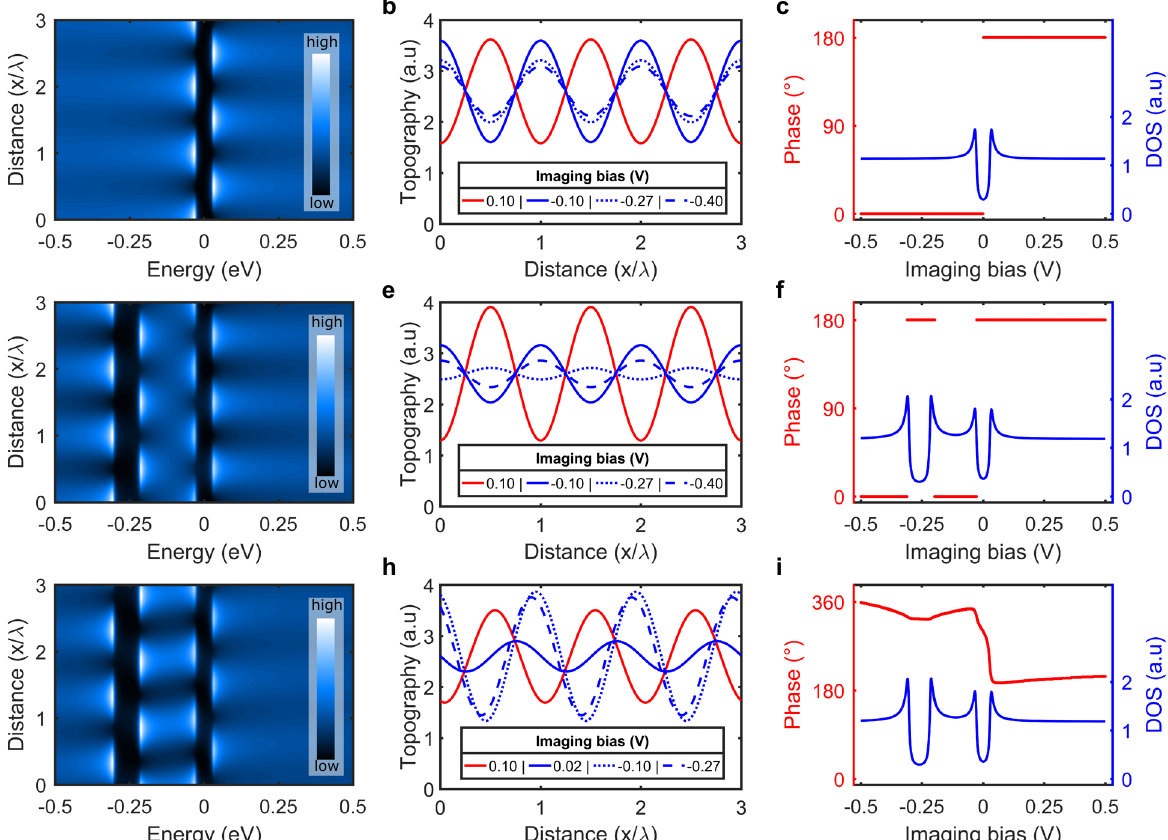
Fig. 4 One-dimensional model description of the bias-dependent phase of the CDW. a – c There is a single CM and the corresponding gap is centred at the Fermi level. d – f There are two CMs with two gaps that are centred at different energies (one at the Fermi-level and one below). There is no real-space phase difference between the CMs. g – i The same as d – f except that there is a 120° (2 π /3) phase difference -one atom shift- between the two CMs. In all three cases, the fi rst column shows the spatial and energy-dependent CDW local DOS maps. Second column: corresponding simulated topographic traces at selected biases (the actual bias value is shown in the legend). The red and blue topographic traces correspond to positive and negative sample biases, respectively. To clearly see the evolution of the phase and the amplitude the curves are offset vertically in b , e and h such that they all oscillate around the same value. Third column: bias dependence of the phase (left red axis) and DOS (spatially integrated local DOS from the fi rst column, right blue axis).